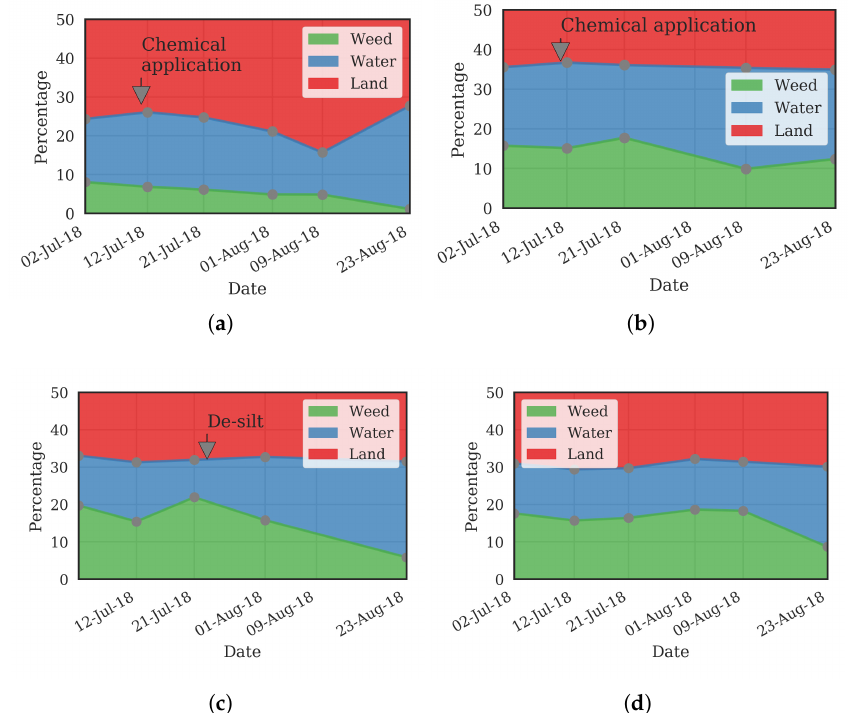
Figure 7. Area of each of the classes over time for the four channels mapped with the UAV. ( a ) C1; ( b ) C2; ( c ) M; ( d )